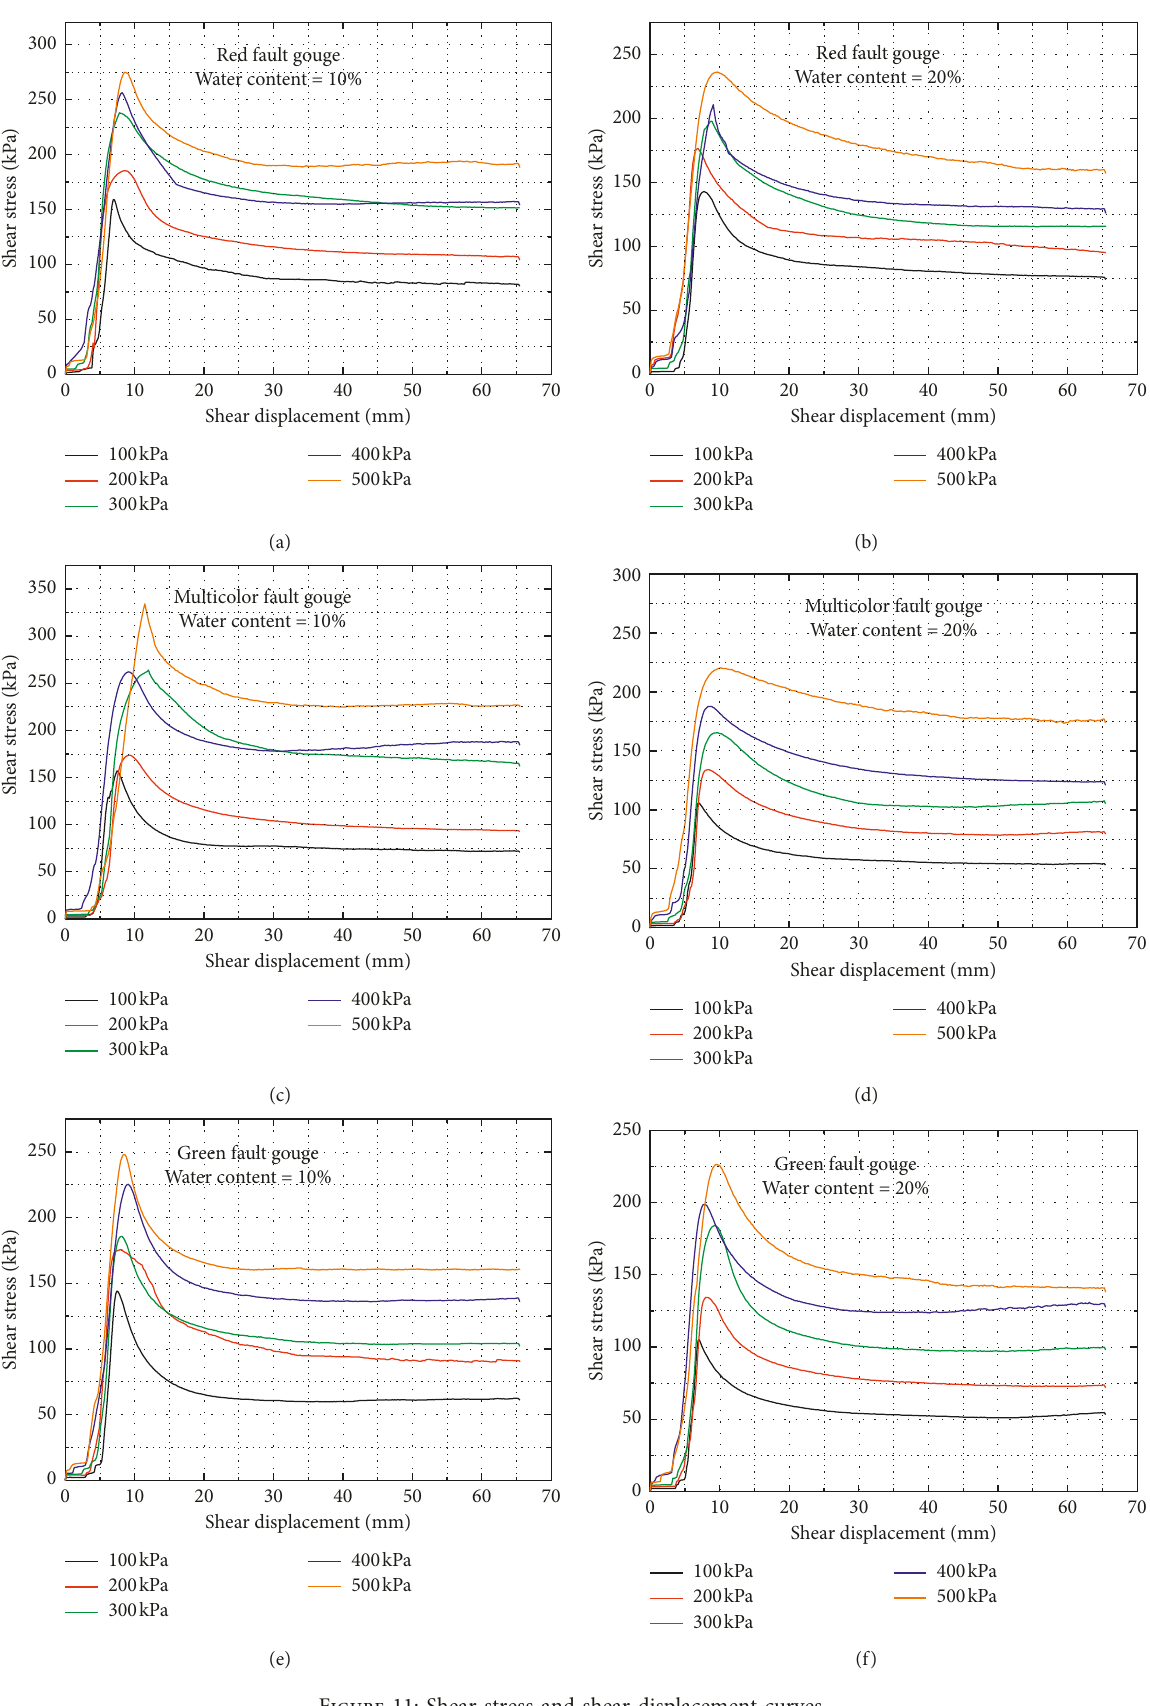
Figure 11: Shear stress and shear displacement